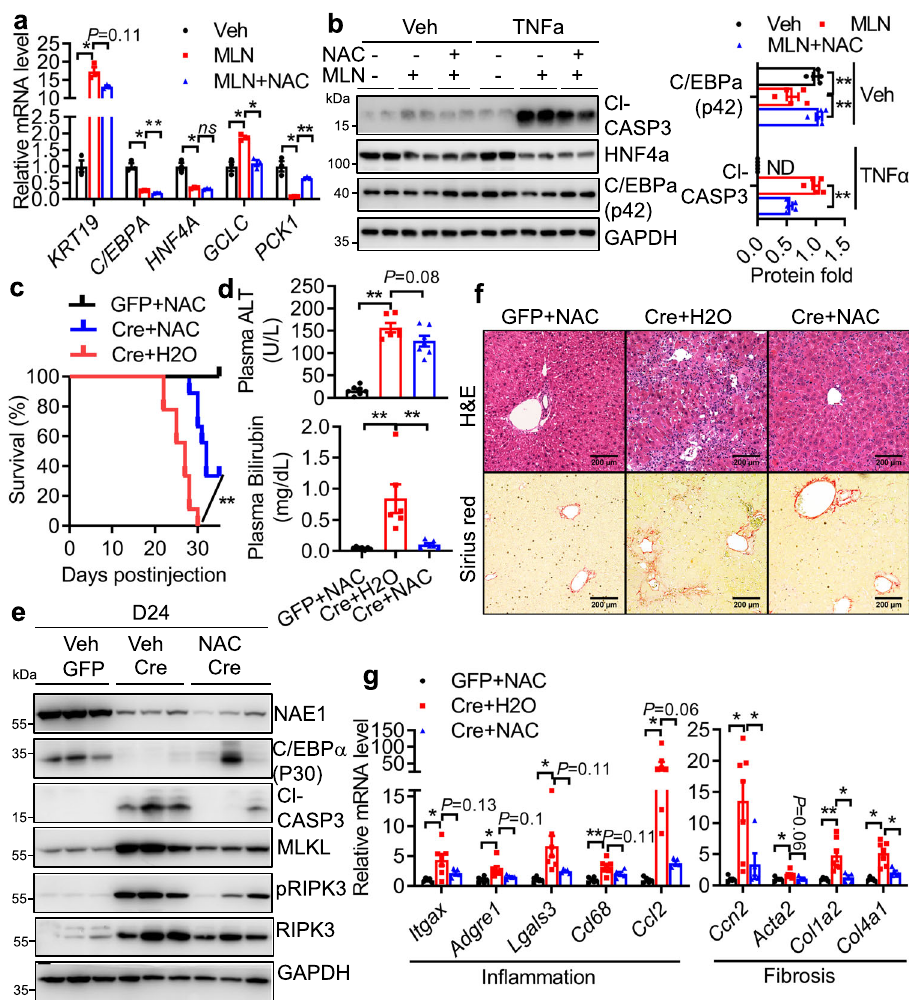
Fig. 8 | NAC ameliorates NAE1 deletion-induced lethal liver failure. a qRT-PCR analyses in HepG2 cells treated with vehicle (Veh), 1.0 µ M MLN with or without 10mM NAC for 48h ( n =3 per group). b Representative Western blot and quanti- fi cations in HepG2 cells treated with Veh, 1.0 µ M MLN with or without 10mM NAC for 48h. 20ng/mL TNF α was added in the last 24h ( n =5). C/EBP α protein expressionwasnormalizedtocellsreceivingVeh.Cleavedcaspase-3activationwas normalizedtocellsreceivingTNF α .Threebiologicallyindependentexperiments.In ( a , b ), Veh (black), MLN (blue), MLN+NAC (blue). Two-way ANOVA followed by Tukey ’ smultiplecomparisonstest.* P <0.05;** P <0.005.ns:notsigni fi cant.ND:not